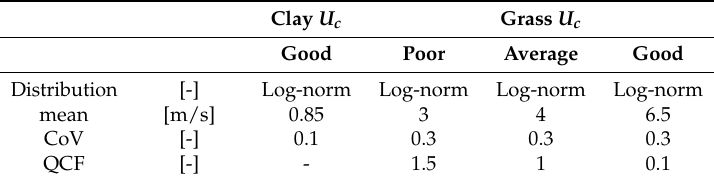
Table 4. Stochastic random variables of cover quality U c used as input for C E calculation. CoV is the coefficient of variation and QCF is grass quality correction factor for poor, average, and good. Clay (cid:2177) (cid:2185) Grass (cid:2177) (cid:2185)